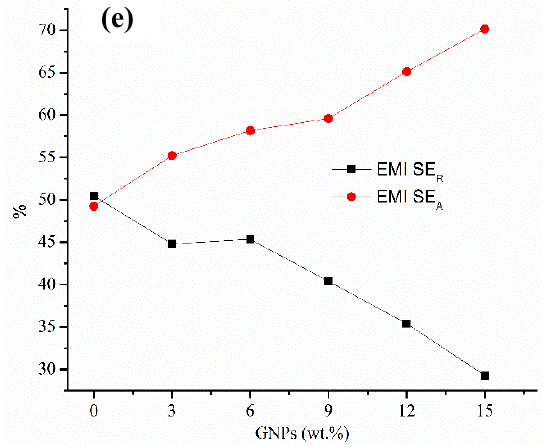
Figure 13. EMI SE plots in X-band: ( a ) SE A , ( b ) SE R , and ( c ) SE T . ( d ) Maximum absorption and reflection at 10 GHz. ( e ) Percent reflection and absorption of ABS+GNP nanocomposites.